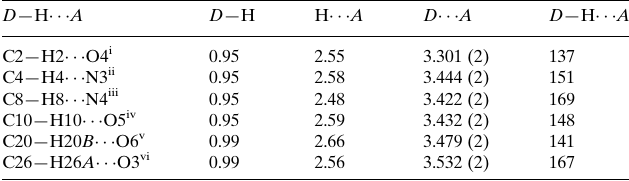
Hydrogen-bond geometry (A˚ , (cid:3)